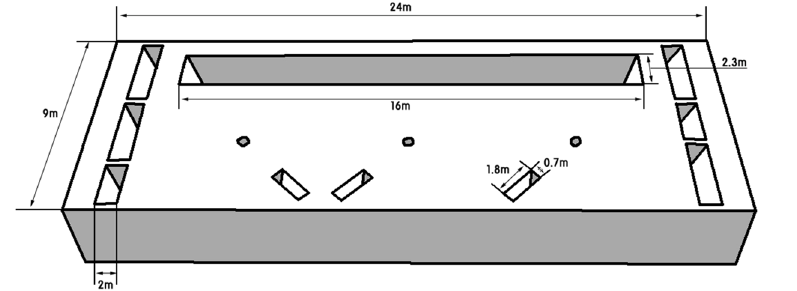
Figure 3. Dimensions of the thermal mesophilic aerobic digestion facility.